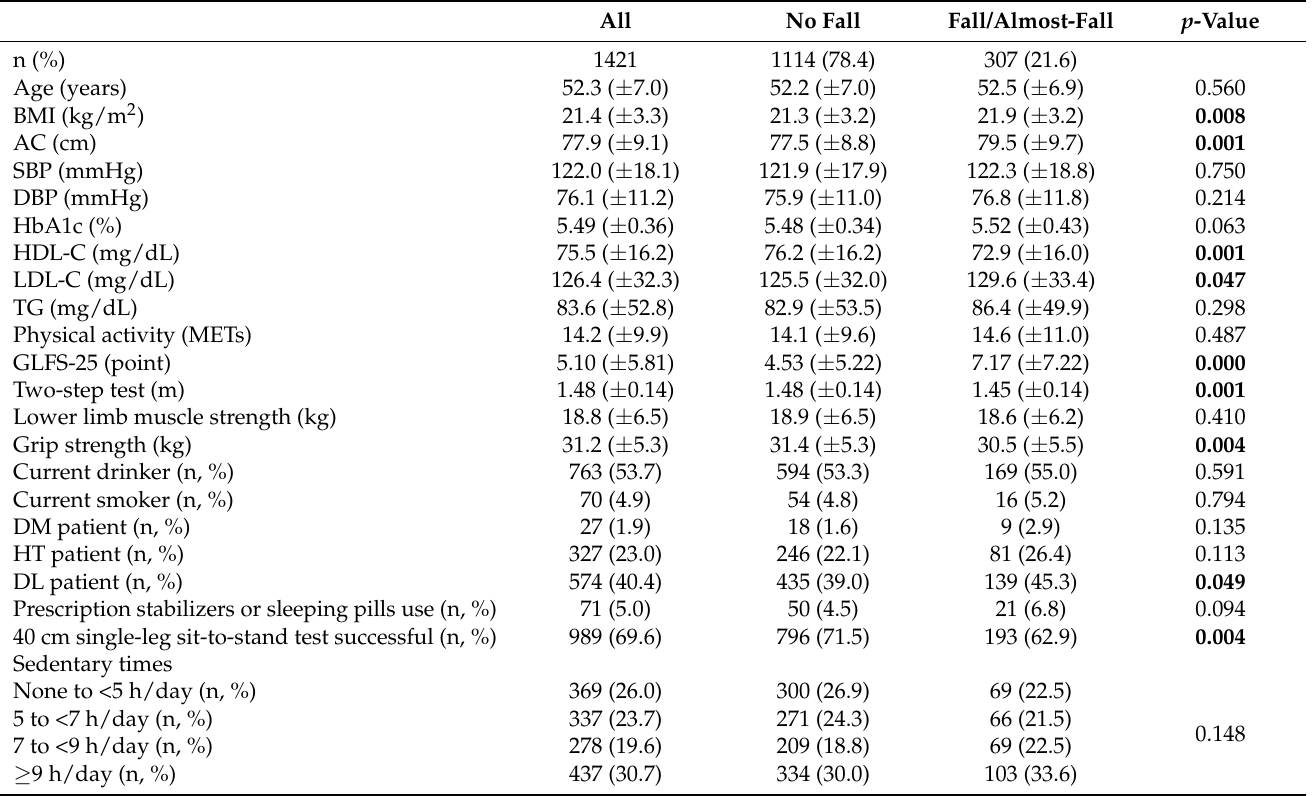
Table 1. Anthropometric, biochemical, and clinical characteristics of the study participants, women aged 40 to 64.